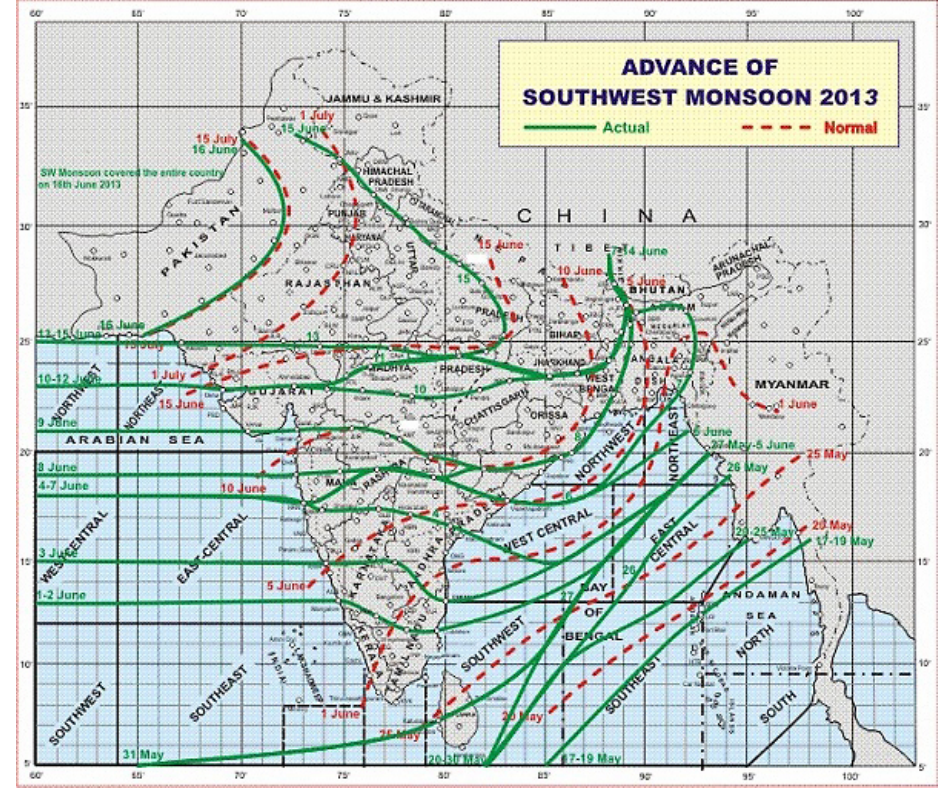
Figure 1. Progress of 2013 Indian Southwest monsoon (Source: http://www.imdpune.gov.in/mons_monitor/mm_index.html).